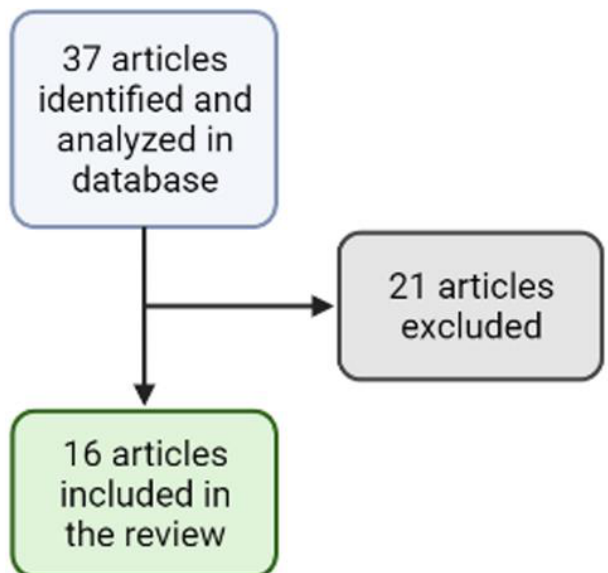
Figure 2. Flowchart of study selection for the narrative review.